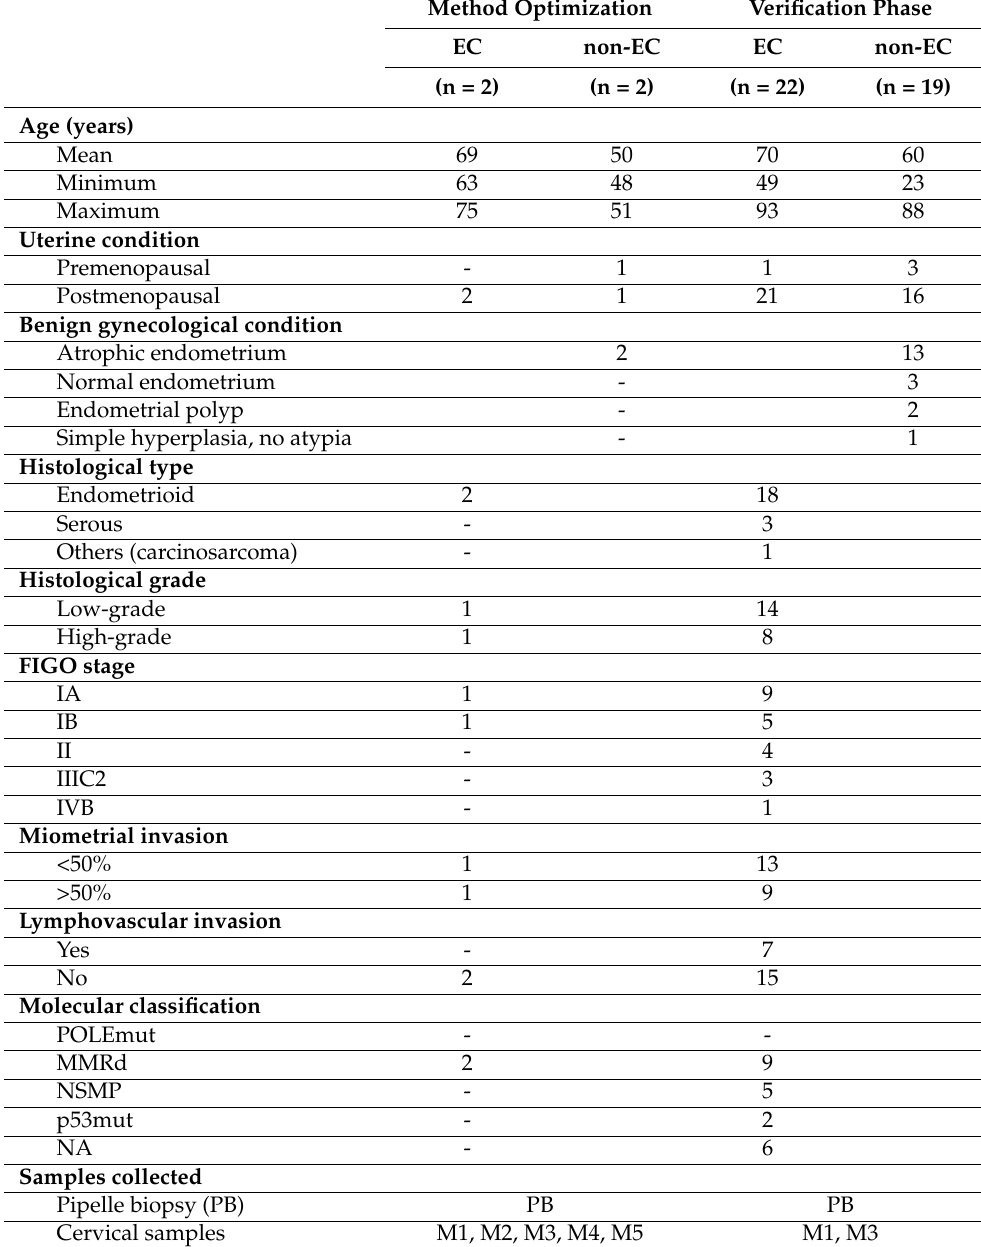
Table 1. Clinicopathological features of the patients included in the study. EC: endometrial cancer; depl: depleted sample from Albumin and